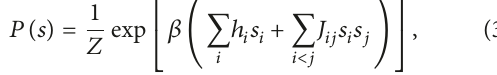
Without loss of generality, we can set the temperature 𝑇 = 1